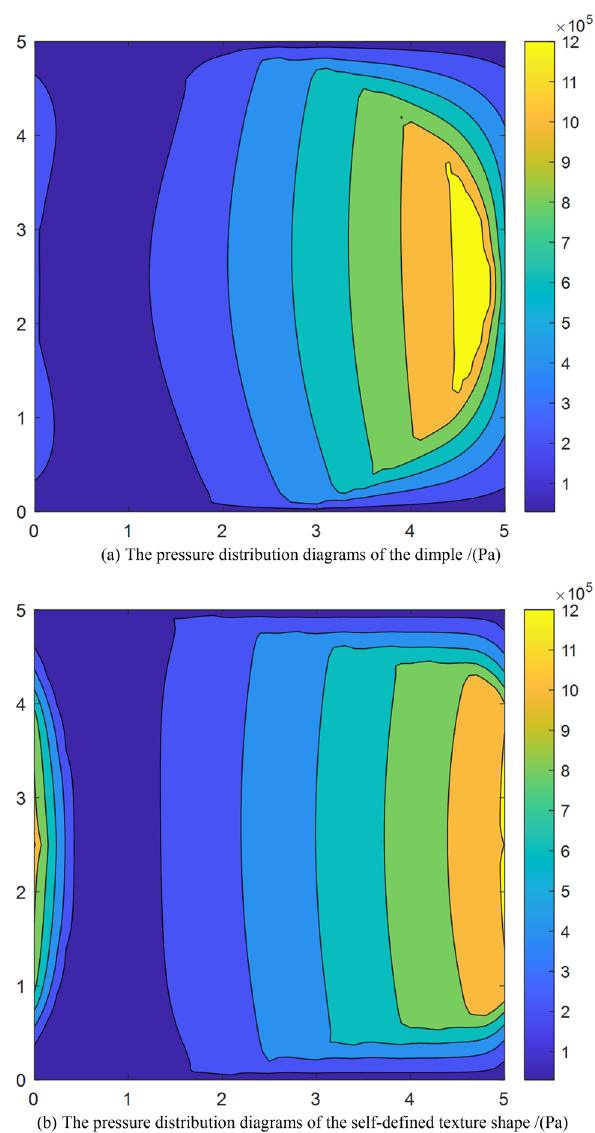
Figure 8. The pressure distribution of the dimple and the self-defined texture